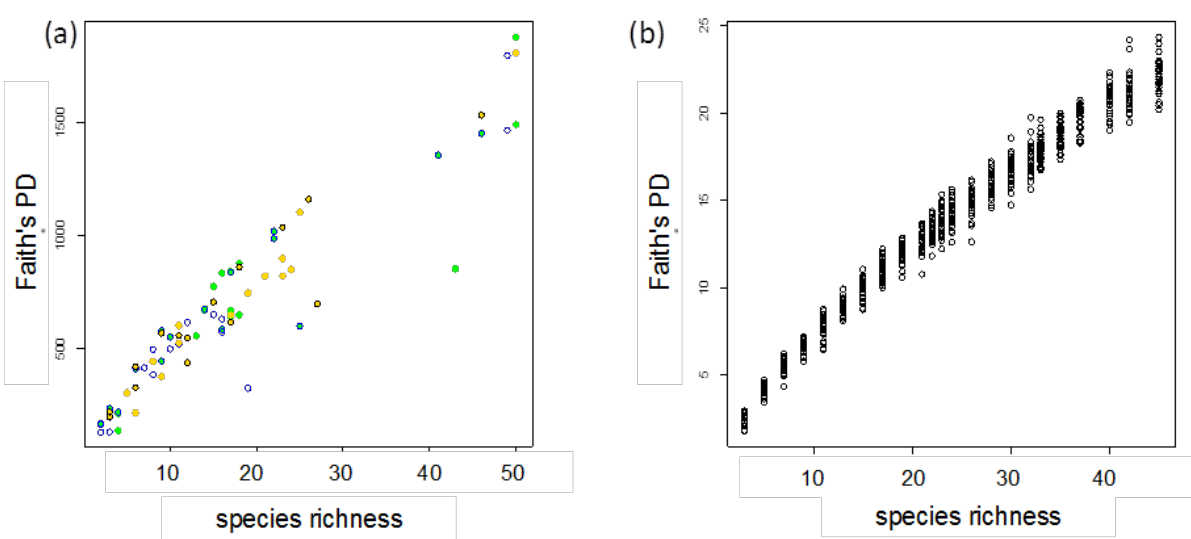
Figure 2. Relationships between species richness and PD for (a) islands with extinctions and introductions: past sce- nario (green, Pearson’s r = 0.89), extant native scenario (yellow, Pearson’s r = 0.95) and present scenario (blue, r = 0.95), and only introductions (black circles, Pearson’s r = 0.96). (b) Using simulated data the relationship between species richness and Faith’s PD is clear (Pearson’s r = 0.98). Data from Sobral et al. (2016) using the R code provided in Villeger et al.